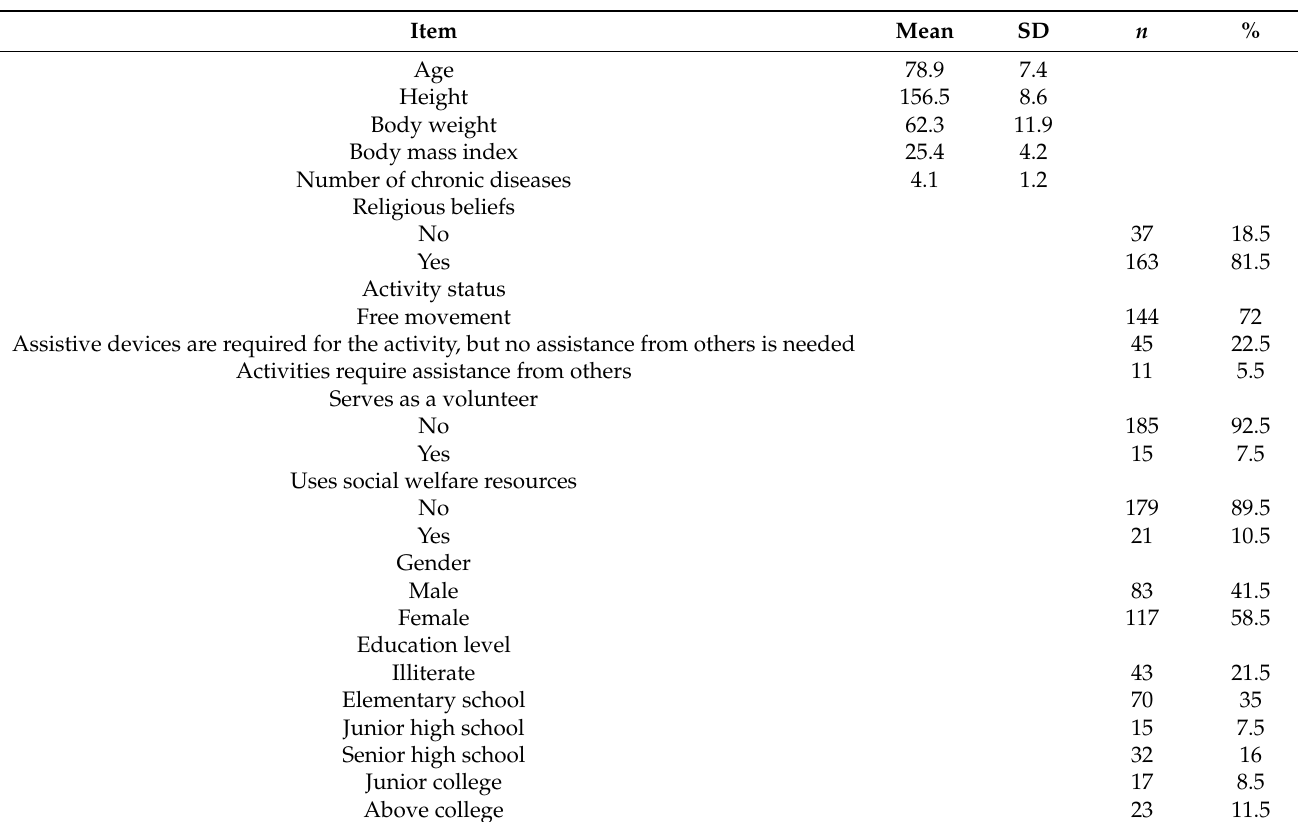
Table 1. Descriptive statistical results of basic demographic data ( n =